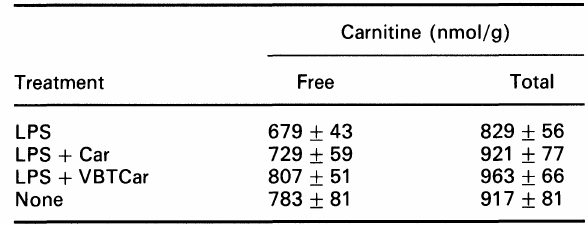
Table 7. Skeletal muscle carnitine levels at 30 h post-LPS Carnitine